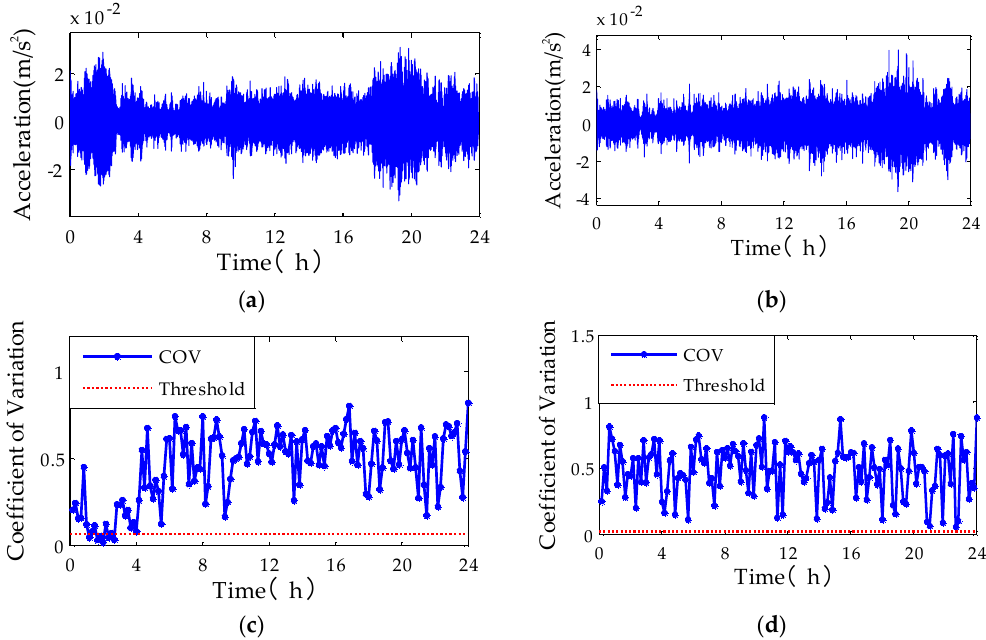
Figure 19. Acceleration responses and the identification results on January 4: ( a ) Acceleration at quarter span; ( b ) acceleration at half span; ( c ) COV and threshold at quarter span; ( d ) COV and threshold at half span.